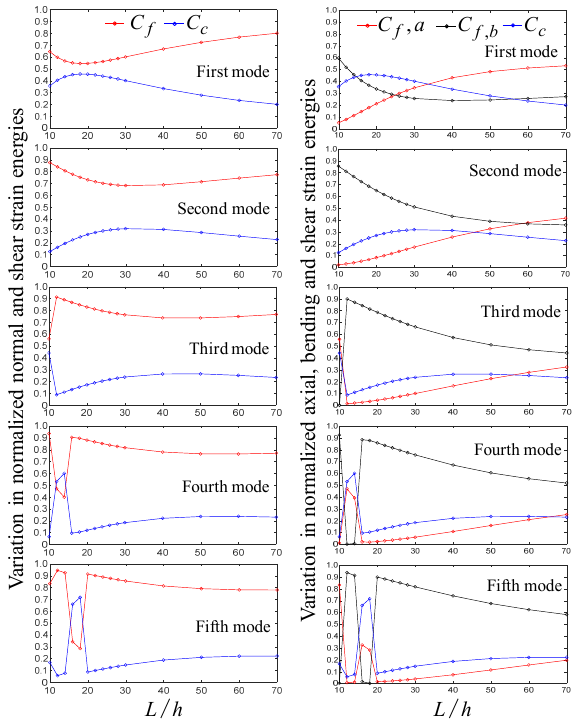
Figure 7. Variation in the strain energies on the natural frequencies of three ‐ layered beams with the P ‐ P end condition.